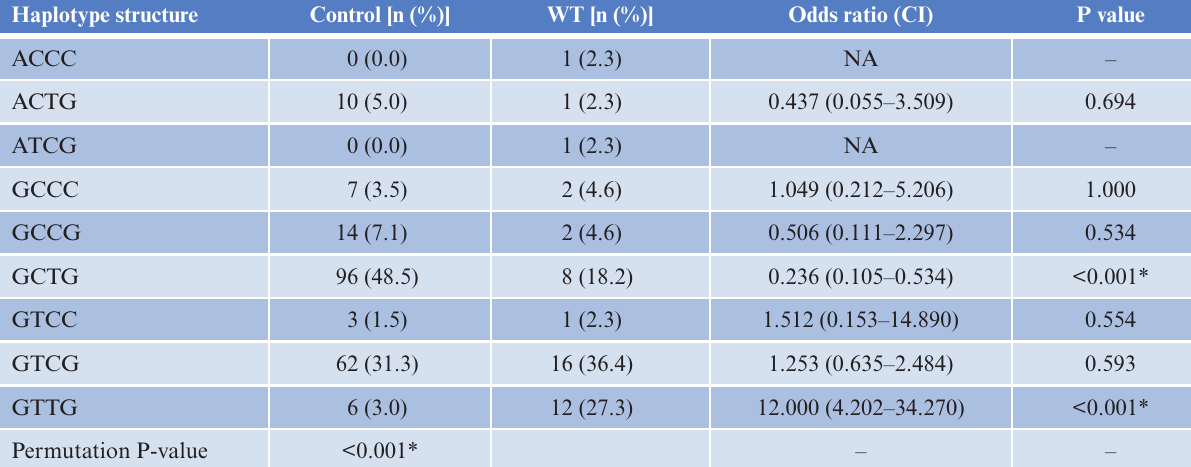
Table 4: Case-control association study for haplotype